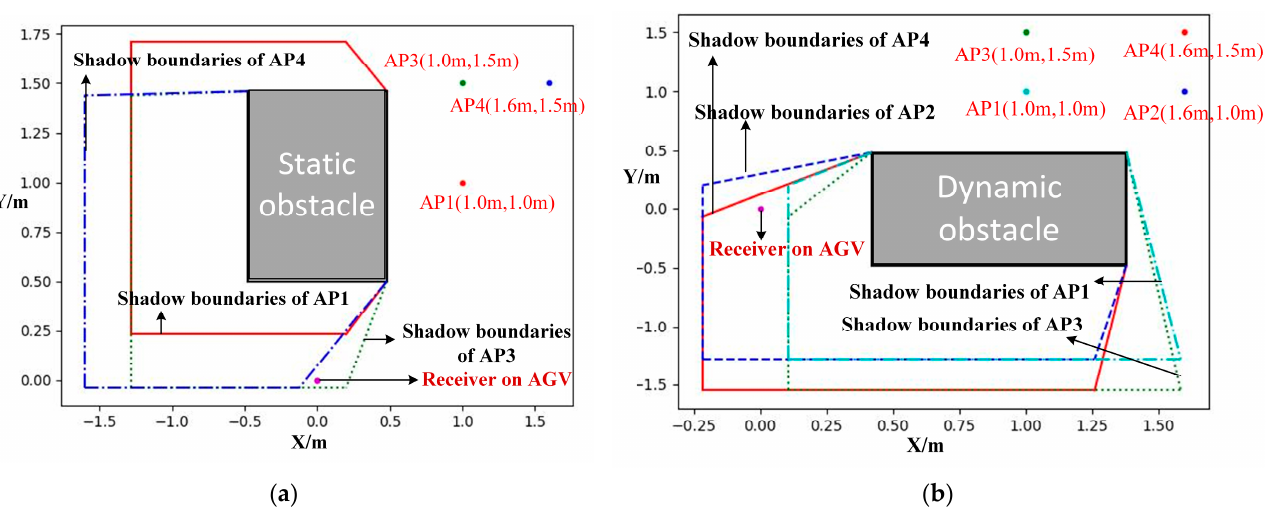
( b ) Figure 9. Shadows of APs under the influence of dynamic obstacles: ( a ) AP1-AP4; ( b )AP5-AP8.